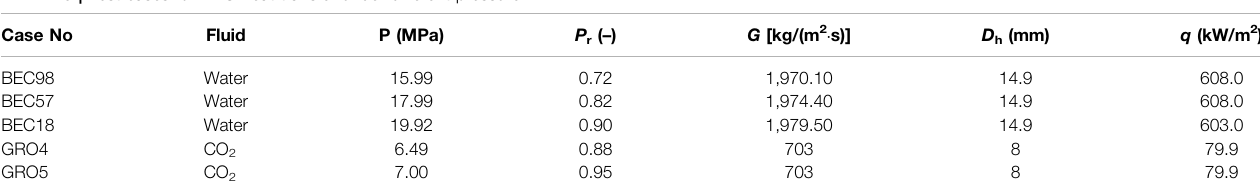
TABLE 9 | Test cases for PDO heat transfer under different